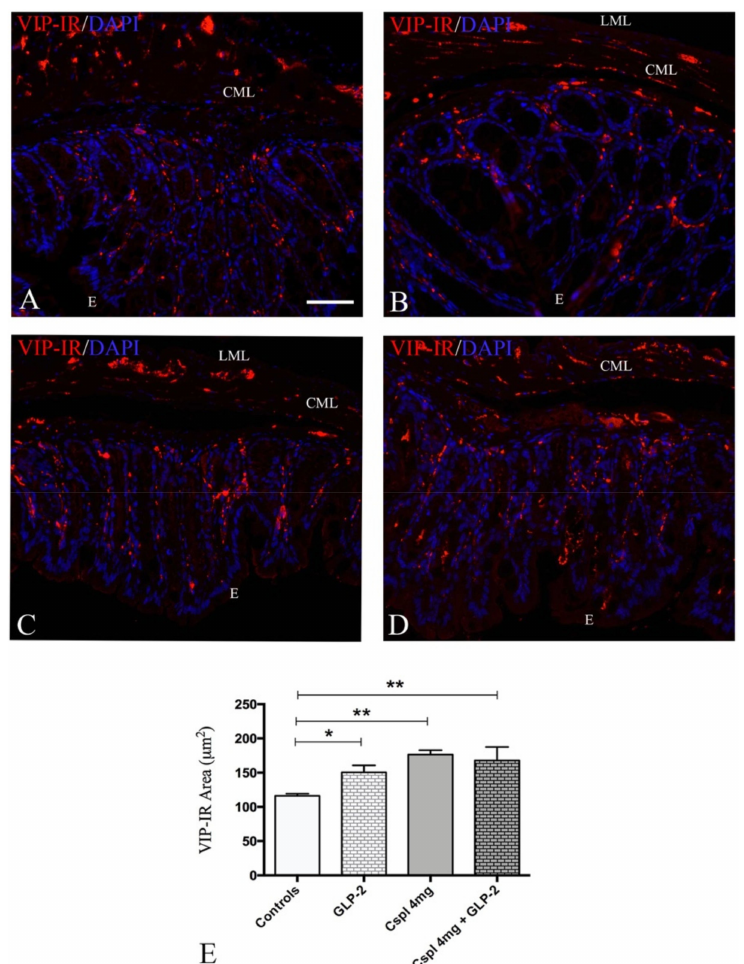
Figure 4. VIP labeling distribution ( A – D ) and quantitation ( E ) in colonic mucosa. Controls ( A ), [Gly2]GLP-2 ( B ), cisplatin ( C ), and cisplatin + [Gly2]GLP-2 ( D ) group. The VIP labeling appeared as small granules located in the fiber varicosities along the villi’s axis and under the epithelium. DAPI labeling stained the nuclei. Scale bar = 50 µ m. ( E ). 40 regions of interest (ROIs) were randomly chosen to analyze at least 24,000 µ m 2 of tissue. Results are expressed as mean ± SEM. One-way ANOVA test, post hoc Newman Keuls’. ** ( p < 0.01), * ( p < 0.05). n = 4–6 for each group. E = Epithelium; CML = circular muscle layer; LML = longitudinal muscle